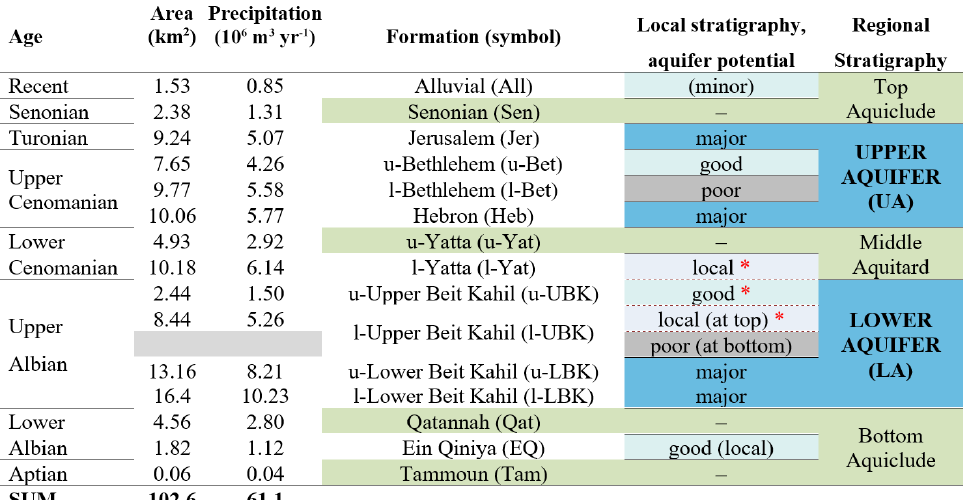
Figure 2. Wadi Natuf land use and land cover (LU/LC) map and regional hydrostratigraphy in shaded colours (modified after LRC, 2004, Messerschmid et al., 2003a, and ARIJ, 2012). Note that the land cover types 4 and 5 are almost completely restricted to Yatta formation outcrops (and in some places parts of the UBK formations). Type 3 is typically found over outcrops of the regional Lower Aquifer. The Upper Aquifer outcrop area is dominated by type 1 (grassland and barren rock). Olives (type 2) can be found in all areas but are grown on tended terraces, mostly in the steep slopes of the Lower Aquifer outcrops in upper Wadi Natuf. Table 1. Outcrop (recharge) area, average precipitation and formation names in Wadi Natuf – regional and local refined